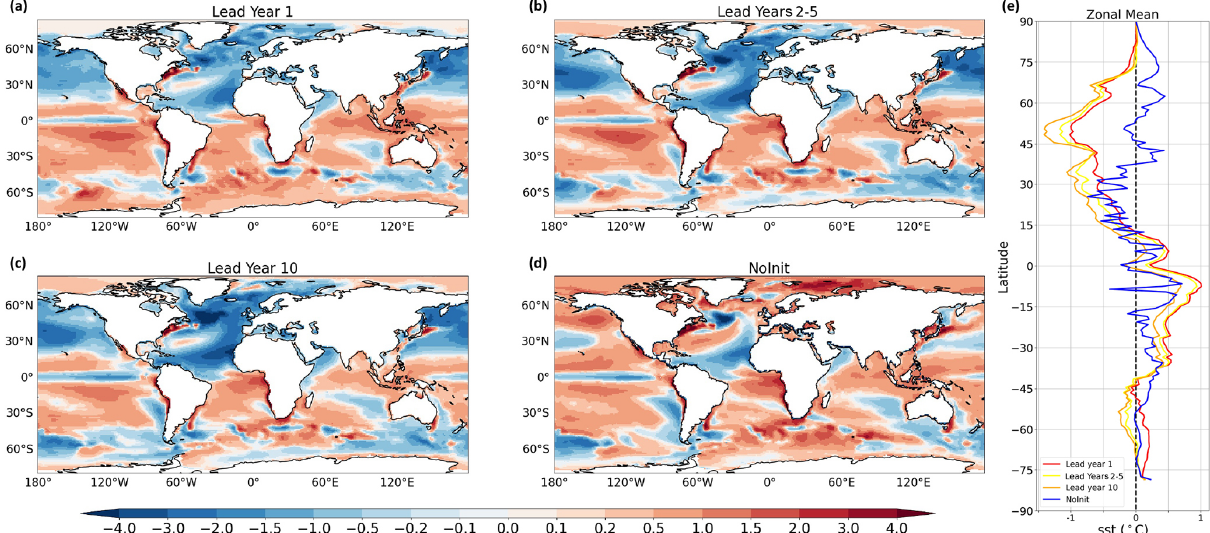
Figure 6. Mean SST bias for (a) year 1, (b) years 2–5, (c) year 10, (d) NoInit runs, and (e) their zonal mean (scaled with the cosine of the latitude) with respect to the 1960–2020 period from the HadISST1.1 dataset (Rayner et al., 2003). The unit is degrees Celsius ( ◦ C).